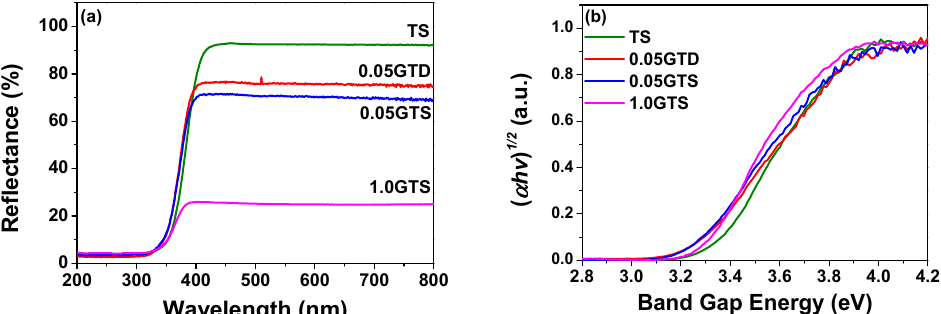
Figure 6. ( a ) UV-visible di ff use reflectance spectra within 200–800 nm; and ( b ) modified Kubelka–Munk ( ( α hv ) 2 ) and band gap energy of pure TiO 2 and the GT composites.